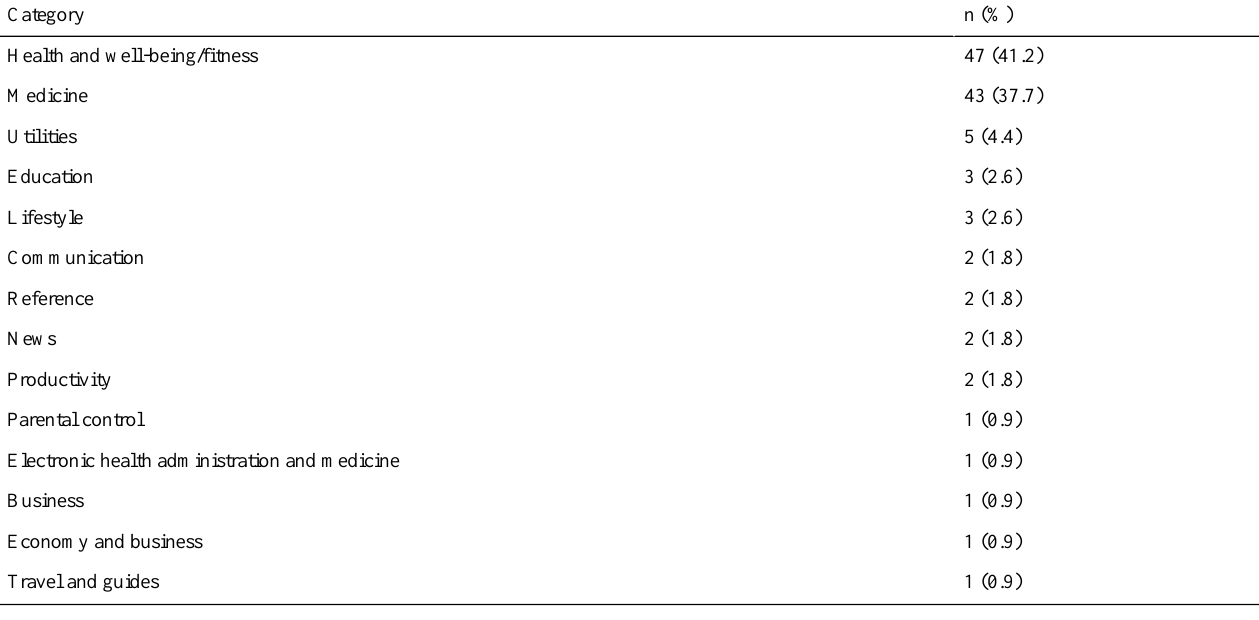
Table 1. Categories of the apps (N=114).